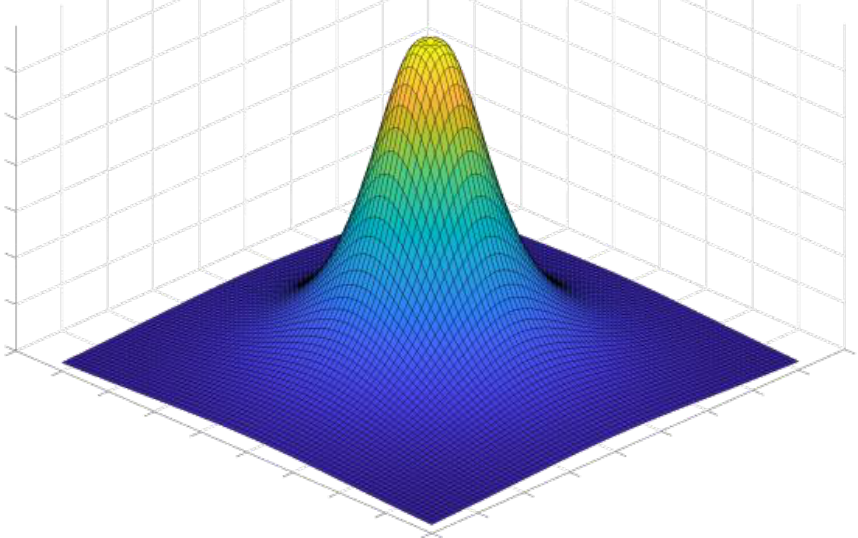
Figure 12. Schematic diagram of surface magnetic field data trend.